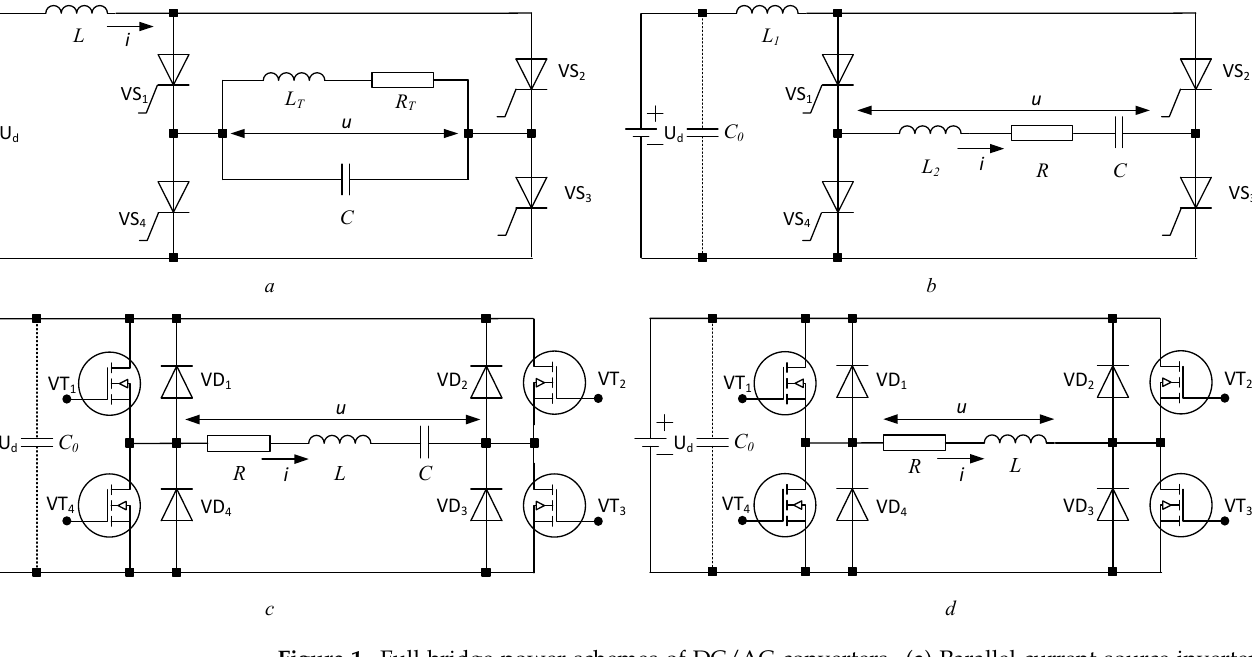
Figure 1. Full-bridge power schemes of DC/AC converters. ( a ) Parallel current source inverter; ( b ) series resonant DC/AC converter; ( c ) resonant DC/AC converter with reverse diodes; ( d ) voltage source inverter.